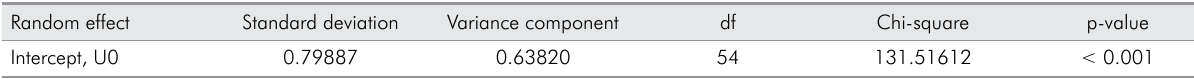
Table 4. Final estimation of variance components in the multilevel analysis (null-model; random